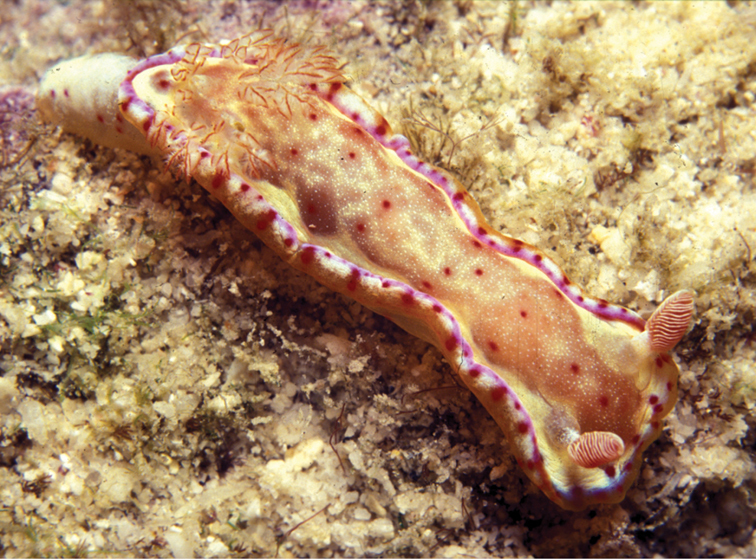
Hexabranchus sanguineus, sub-adult, Seychelles, photo: P Kemp (no spcm).